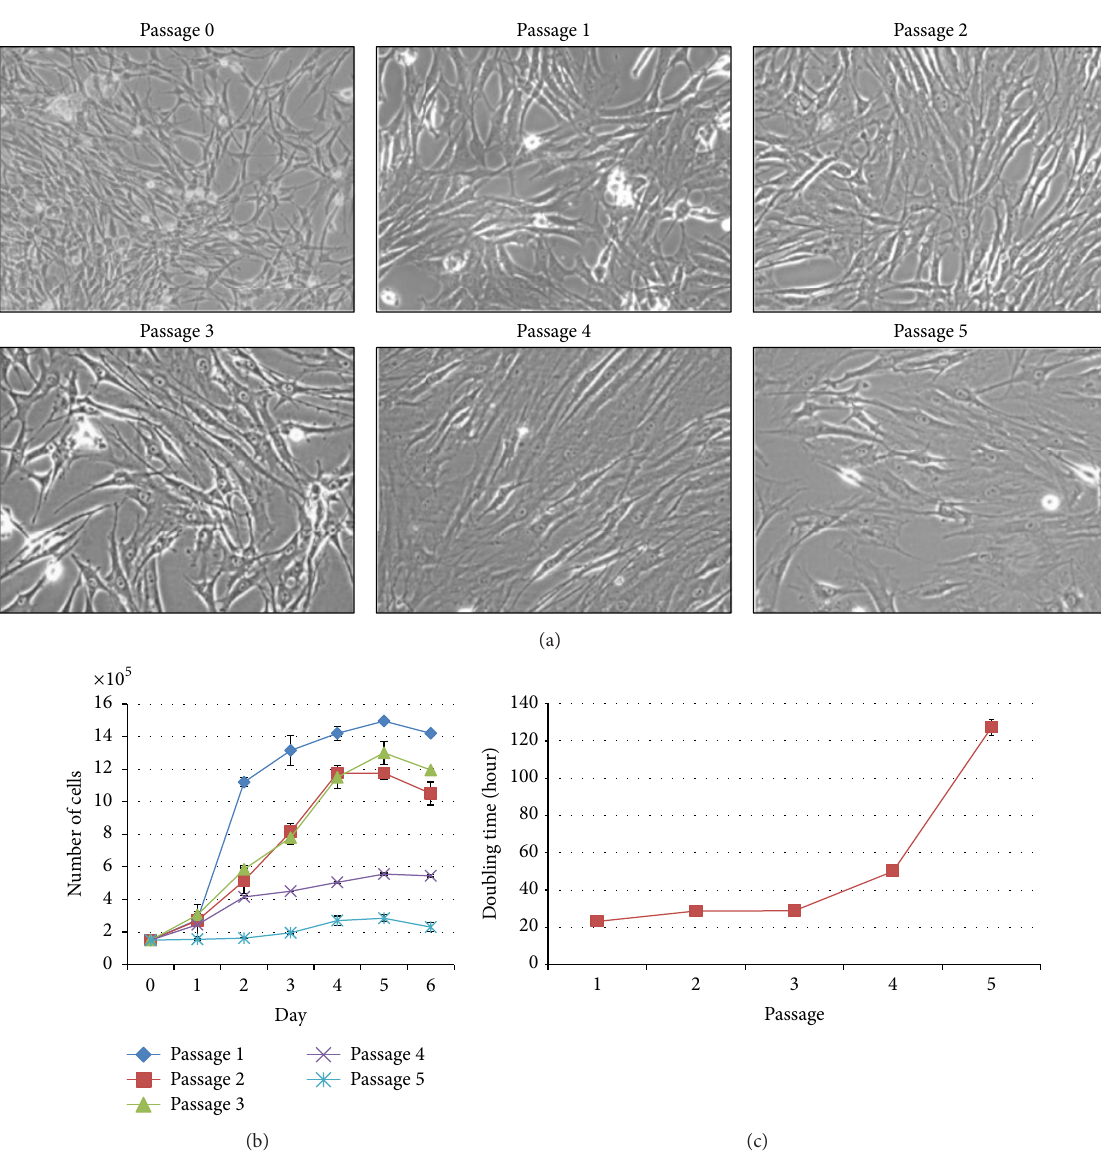
Figure 3: Growth kinetics and doubling time of rBM-MSC. Morphological observation of rBM-MSC cultured in LDMEM (20% FBS) in the presence of 20 ng/mL, 1% ITS, and 1% NEAA at various passages. Cells were successfully expanded until passage 5 and assumed a spindle- shaped fibroblast-like morphology. As the passage increased, polygonal and flatten shaped cells were predominating (a). Rat BM-MSCs were plated in 6-well plate at 150,000 cells/well, and media were changed every 2 days for 6 days. Cellsdepicted an initial lag phase for1 day, followed by exponential log phase for 4 days, and then a plateau phase was observed (b). Doubling time was determined by Patterson Formula (∗) and expressed as mean doubling time (c). The result represented the mean ± SD. Microscopic magnification: